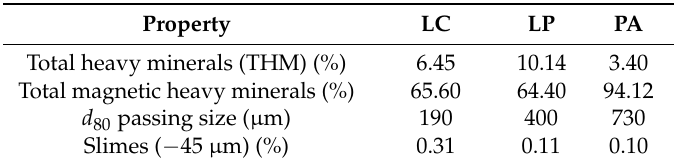
Table 1. Classification of the three samples.